Question: Condense the content of this figure into a single sentence.
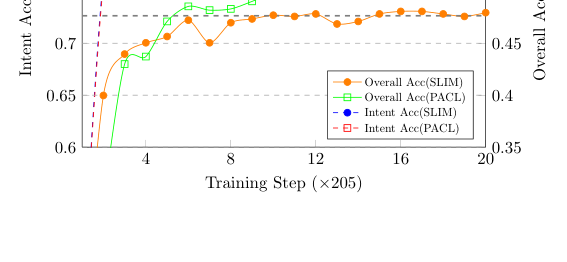
Answer: The learning curve of intent accuracy and overall accuracy on MixATIS test set every fixed validation step.